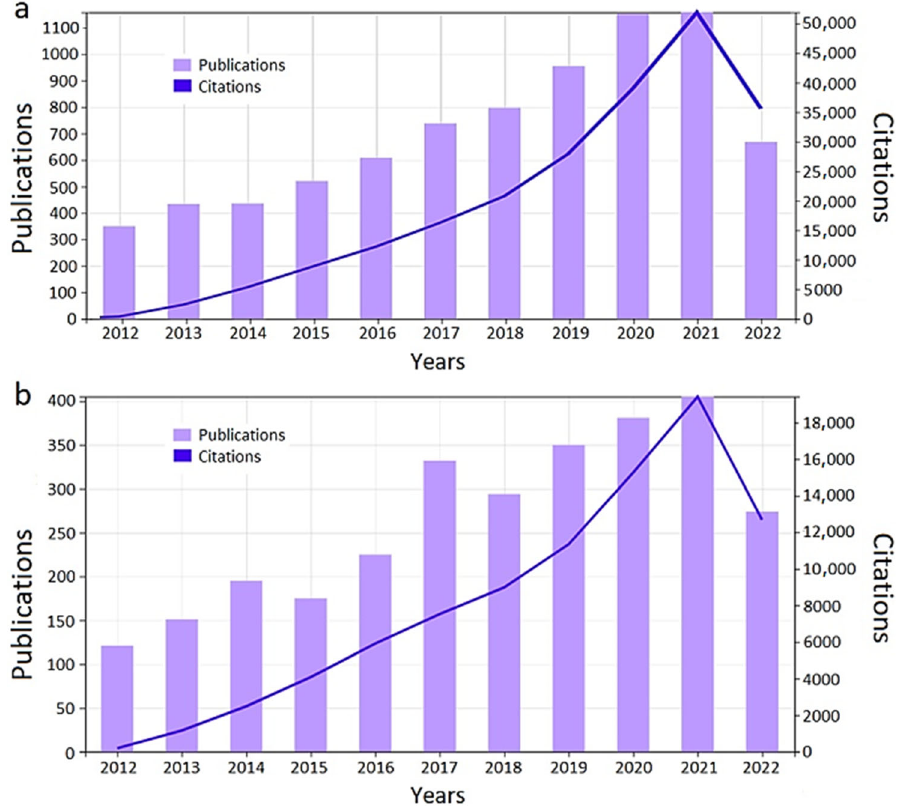
Figure 4. Number of publications and citations in the last 10 years related to ( a ) nanoparticles used for brain diseases and ( b ) nanoparticles developed for glioblastoma treatment.